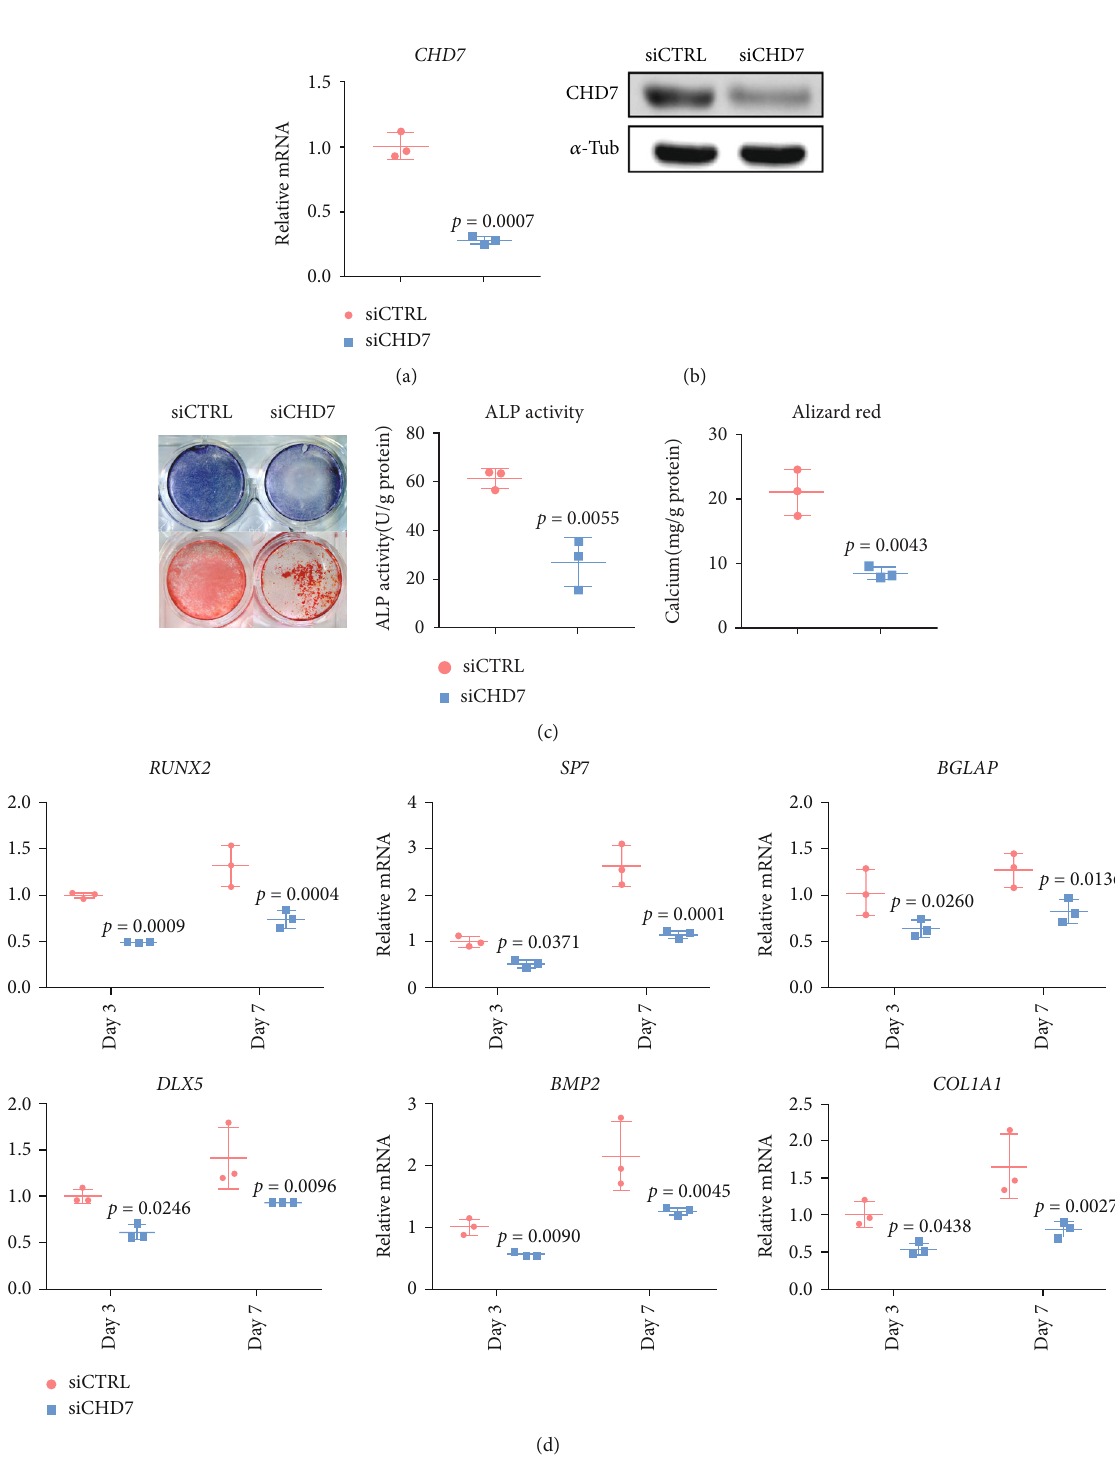
Figure 2: Depletion of CHD7 decreases osteogenic di ff erentiation of hDFCs. (a), (b) qRT-PCR and Western blot veri fi ed the knockdown e ffi ciency of siCHD7. (c) Representative images and quantitative analyses of ALP and ARS staining of hDFCs in the siCHD7 and siCTRL group. (d) qRT-PCR analyses of the expression of RUNX2 , SP7 , BGLAP , DLX5 , BMP2 , and COL1A1 under osteogenic 2.11. Statistical Methods. All data were calculated as the cell harvesting, SDS lysis bu ff er with protease inhibitor mean ± standard deviation (SD). Statistical di ff erence was cocktail (Roche) was added. After ultrasonication, centrifu- calculated via Student ’ s t test for independent sample test gation, and precipitation with beads, the precipitated DNA or one-way ANOVA for multiple comparison. P value less samples were quanti fi ed with speci fi c primers using real- than 0.05 was considered statistically signi fi cant. time PCR [21].